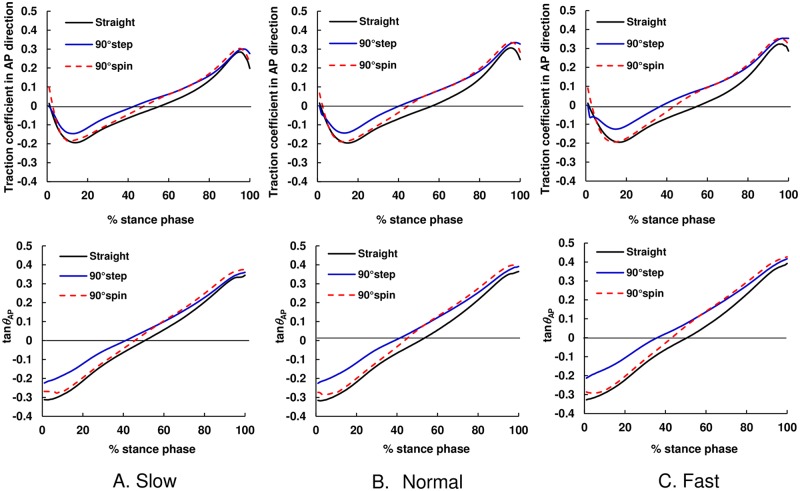
The average temporal pattern of mean values of traction coefficient and tangent of COM–COP angle in the AP direction during straight walking and turning.The black solid line shows straight walking, blue solid line shows 90° step turns, and red dashed line shows 90° spin turns. (A) Slow, (B) Normal, and (C) Fast.